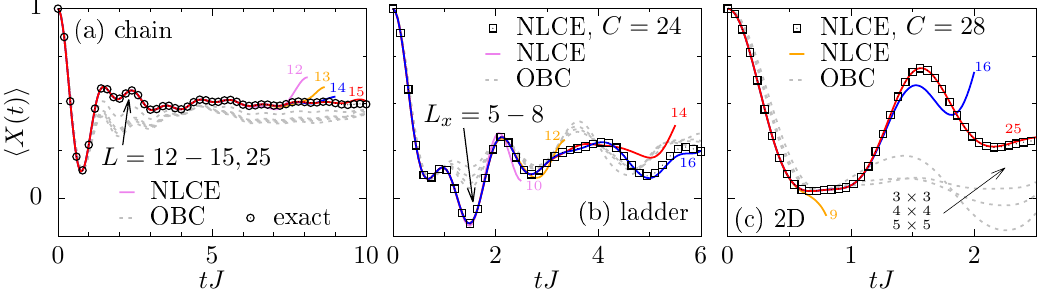
Figure 9: Dynamics of the tranverse magnetization 〈 X ( t ) 〉 for quenches in (a) chains × 2) with g = 0.5, and (c) two- with g = 0.5, (b) two-leg laddders ( L = L x dimensional lattices with g = 0.1 g . The initial state is | ψ ( 0 ) 〉 = |→〉 . Results ob- c tained by numerical linked cluster expansion for different expansion orders C (solid curves) are compared to direct simulations for systems with open boundary condi- tions (gray dashed curves). In all cases, we find that for a given expansion order C (or system size L ) the NLCE yields converged results for significantly longer times than the corresponding direct simulation with